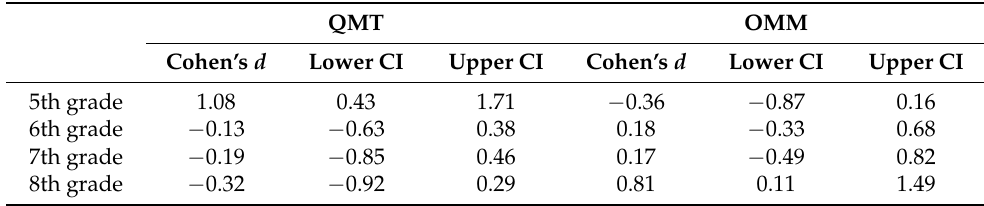
Table 3. Effect size (Cohen’s d) and 95% confidence intervals for ∆ Flexibility following QMT (left) and OMM (right) in each class.